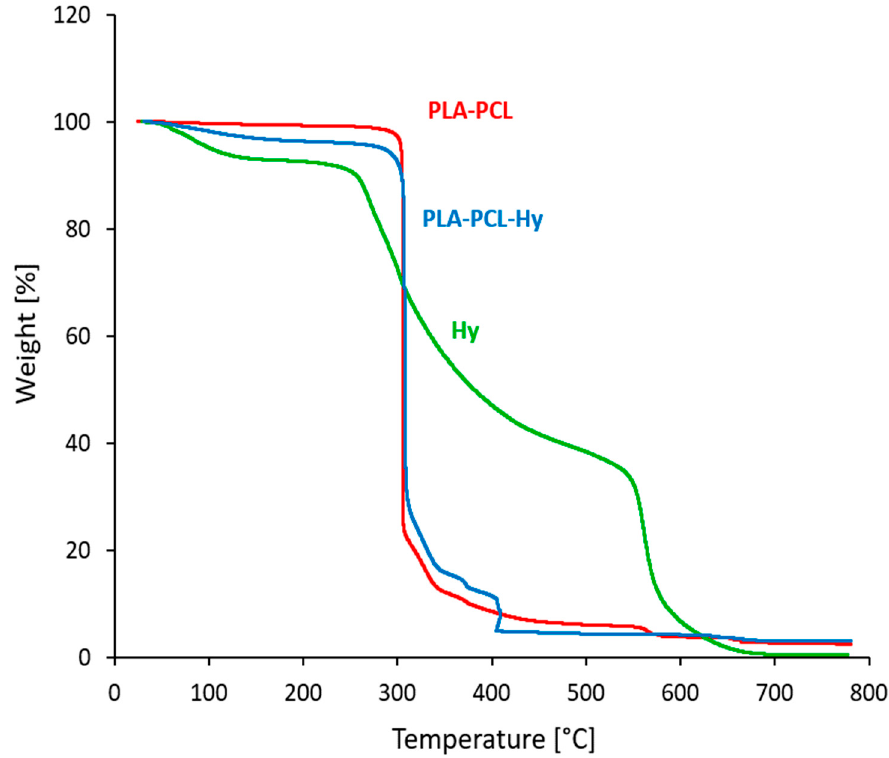
Figure 2. TGA traces of the uncoated core (PLA-PCL), of the assembled core-shell system (PLA- PCL-Hy) and of the neat hydrogel (Hy). Table 1. Composition and absorbed water of PLA-PCL-SAP, PLA-PCL and PLA-PCL-Hy. Table 1. Composition and absorbed water of PLA-PCL-SAP, PLA-PCL and